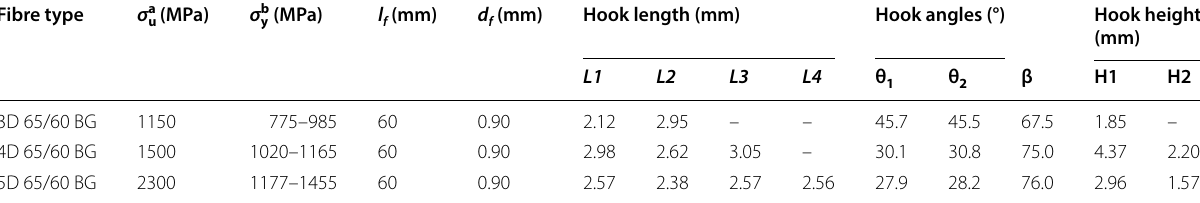
a Ultimate strength. b Yield strength.